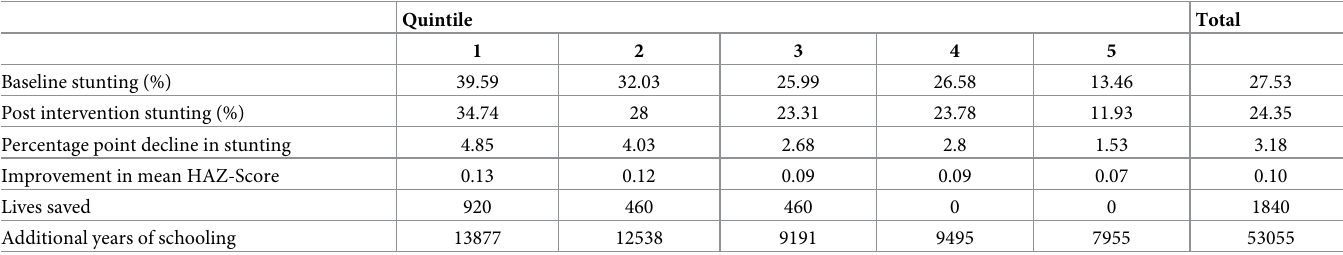
Table 3. Improvements in stunting at 24 months, mean HAZ-score, lives saved and additional years of schooling as a result of nutrition intervention scale up.